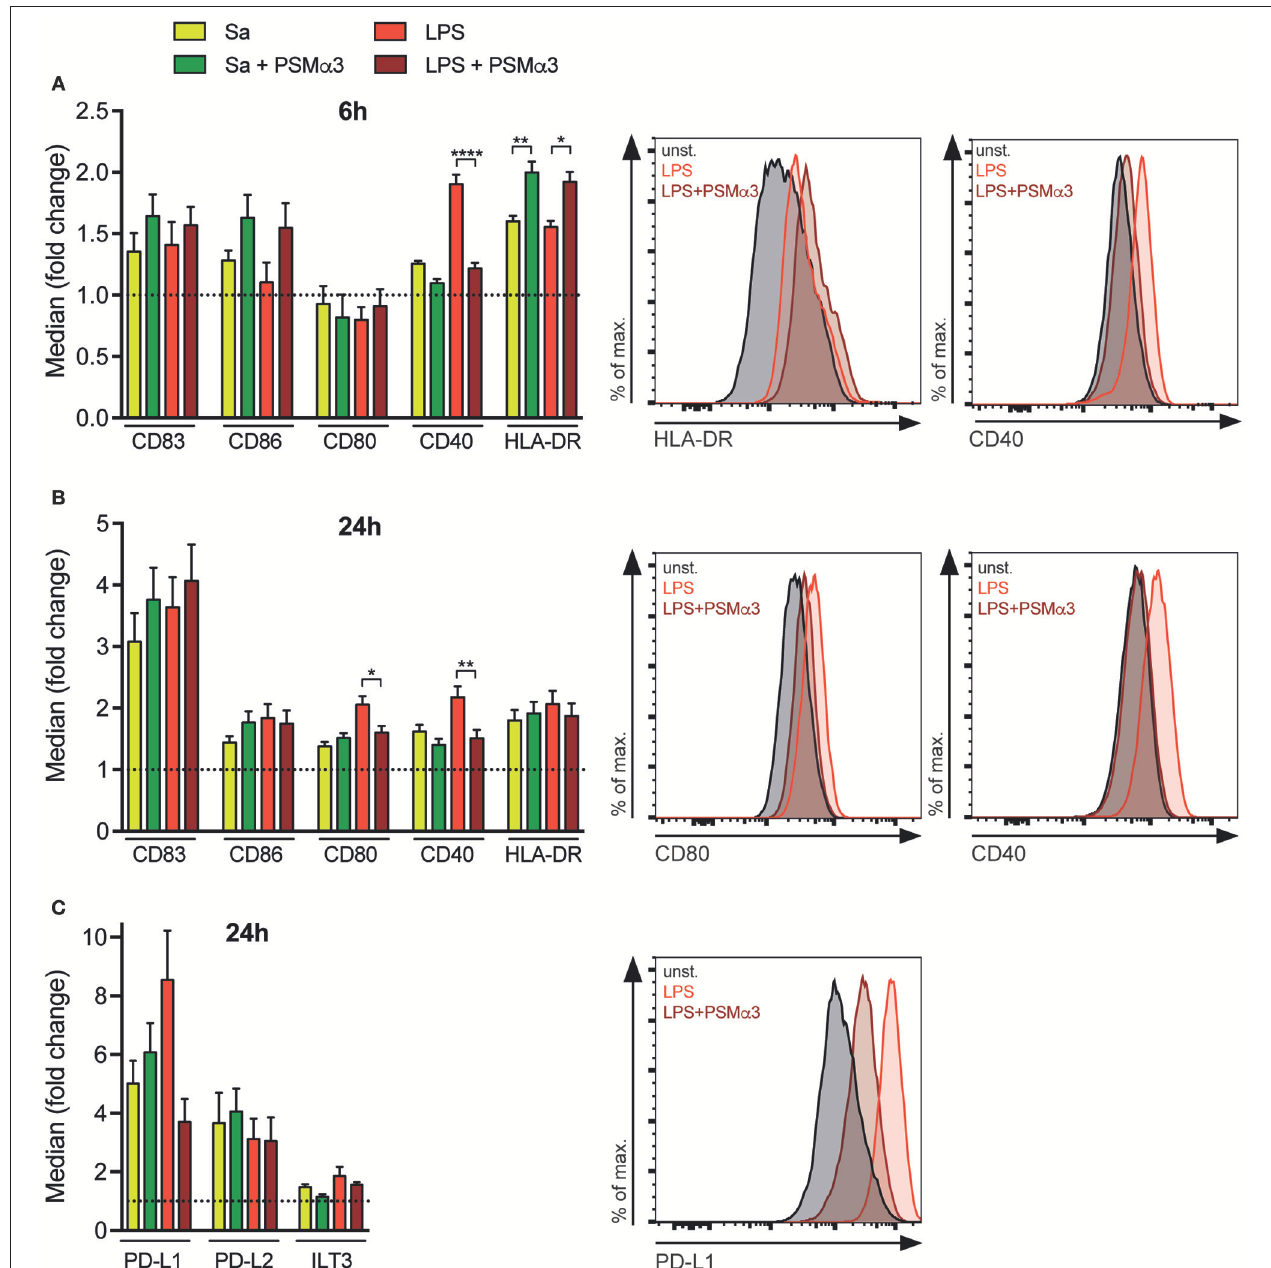
FIGURE 1 | PSMs modulate surface molecule expression of TLR-treated moDCs. MoDCs were treated with Sa lysate or LPS with or without PSM α 3 for 6h (A) or 24h (B,C) and analyzed by flow cytometry. MoDCs were characterized as living CD11c + HLA-DR + cells and the expression of the indicated costimulatory (A,B) and inhibitory molecules (C) was determined. The graphs show the mean fluorescence intensity of the respective marker expression as fold change of untreated cells. The graphs show n ≥ 3 independent experiments (mean ± SEM) performed in triplicates. Representative histogram overlays of HLA-DR and CD40 after 6h (A) , CD80, CD40 (B) , and PD-L1 (C) after 24h. * p < 0.05, ** p < 0.005 or **** p < 0.0001, one-way ANOVA with Turkey’s posttest or Kruskal-Wallis with Dunn’s posttest.